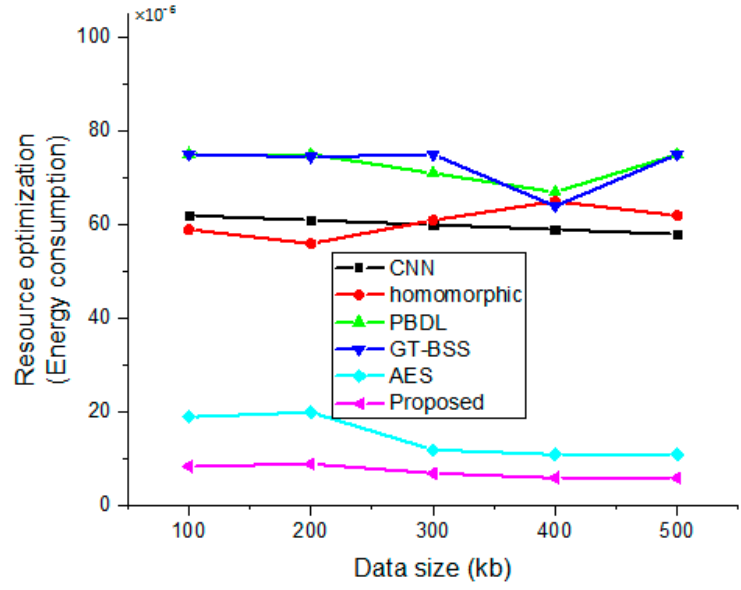
Figure 11. Correlation between data size and energy consumption optimization.